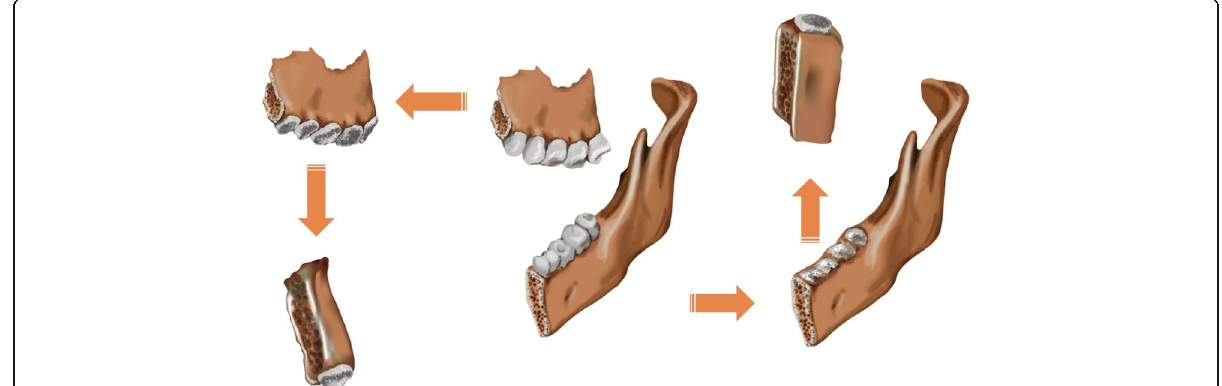
Fig. 1 Evaluation of the 3D alveolar bone morphology. The concept of this preliminary study is to evaluate the ideal three-dimensional alveolar bone morphology by dividing the single tooth block on 3D reconstruction maxilla and